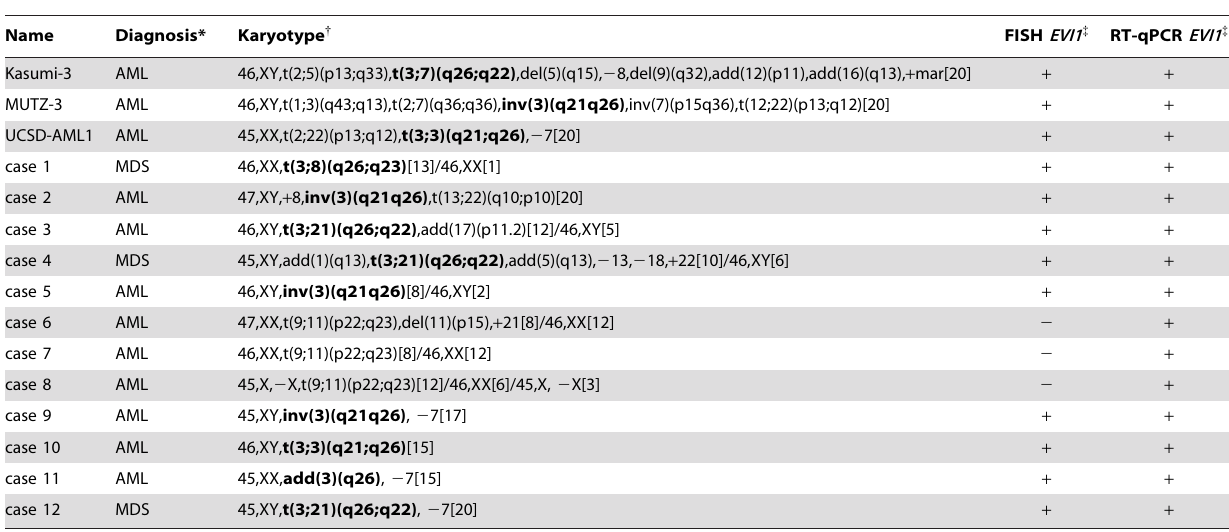
Table 1. Patient and cell line characteristics: diagnosis, karyotype and EVI1 FISH and RT-qPCR results.